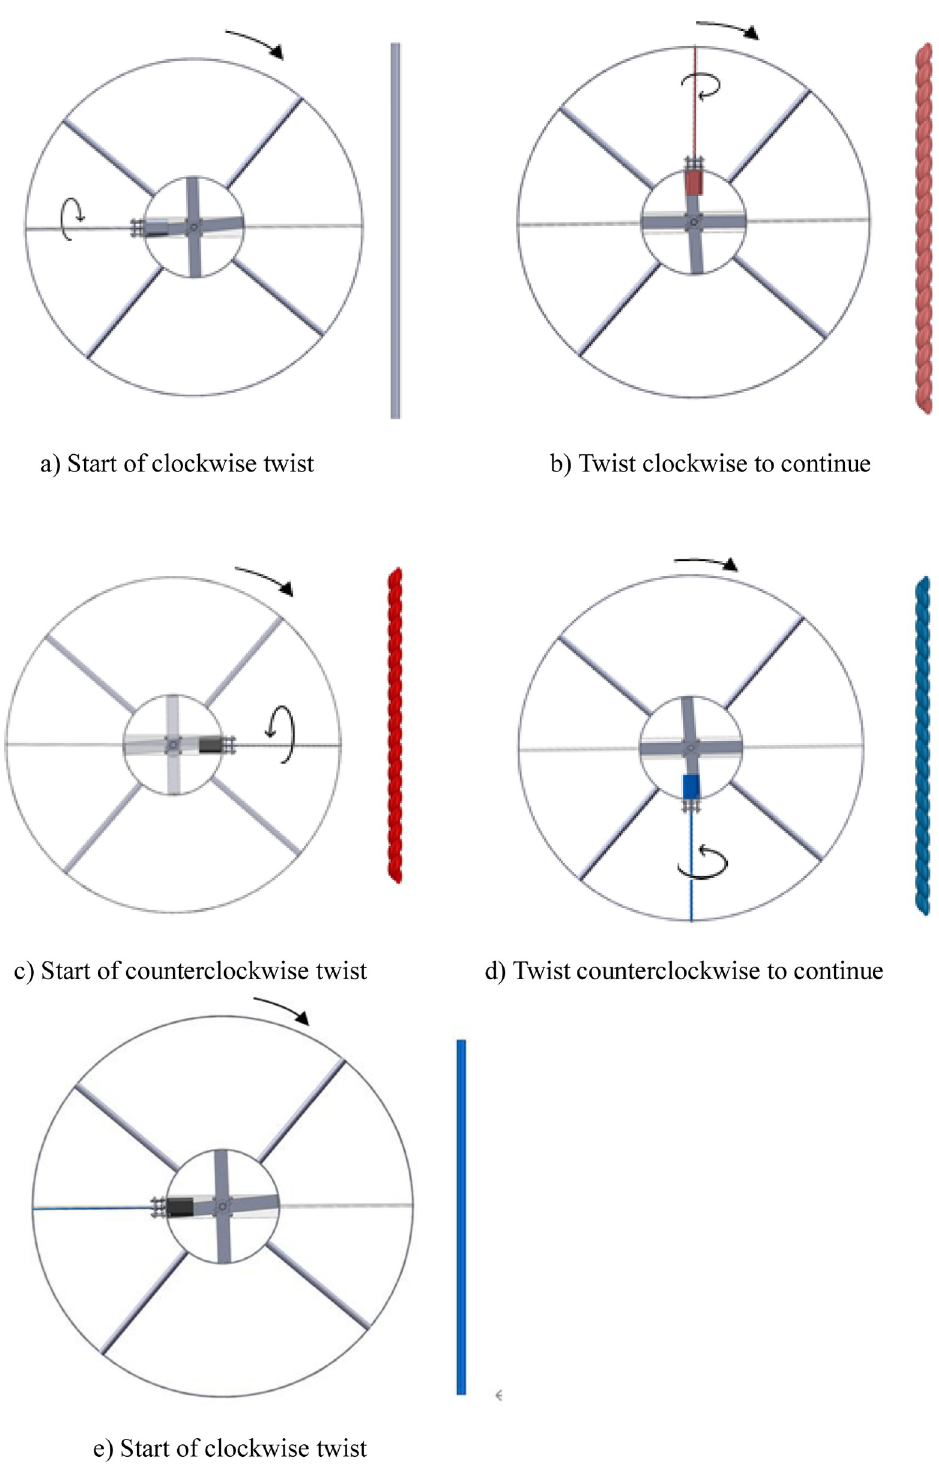
Fig 2. Schematic of the twisted deformation of a nitinol wire during a single operating cycle of the continuous torsional refrigeration system. a) Start of clockwise twist. b) Twist clockwise to continue. c) Start of counterclockwise twist. d) Twist counterclockwise to continue. e) Start of clockwise